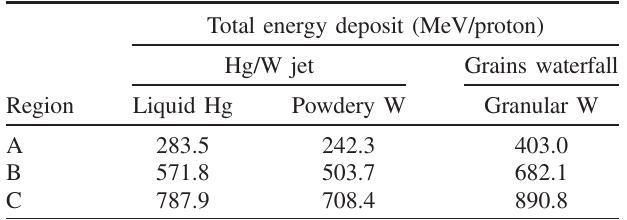
TABLE III. Heat deposited (per proton) in three different regions (inner beam profiles) of the jets and the grain waterfall. Total energy deposit (MeV/proton) Hg/W jet Grains waterfall Region